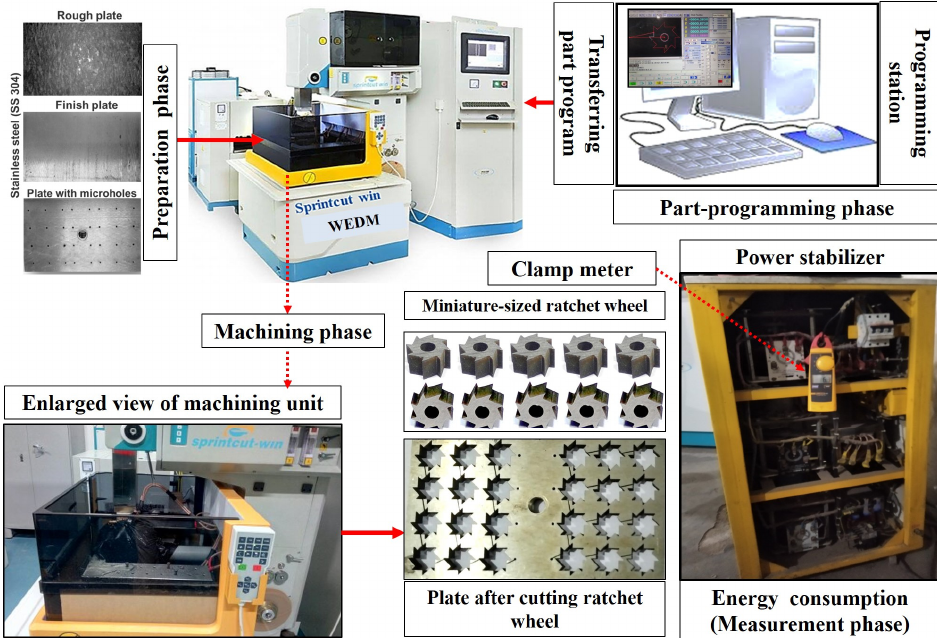
Figure 3. Different phases involved in the manufacturing of miniature-sized ratchet wheels by